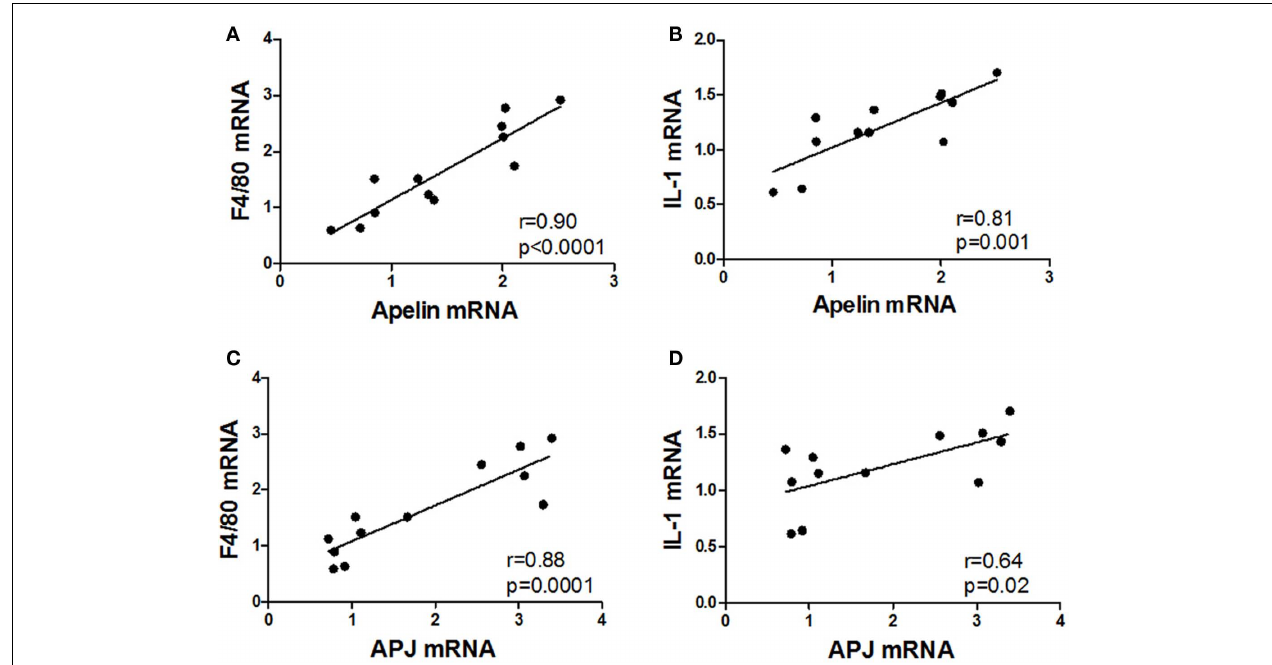
FIGUREA1 | Multiple correlation analyses between the apelinergic system and inflammation. Pairwise correlations between F4/80 or IL-1 and apelin (A,B) or APJ (C,D) mRNA expression measured in the adipose tissue of db / db mice. Insets in each graph depict Pearson’s correlation value of the coefficient (r) and P values.